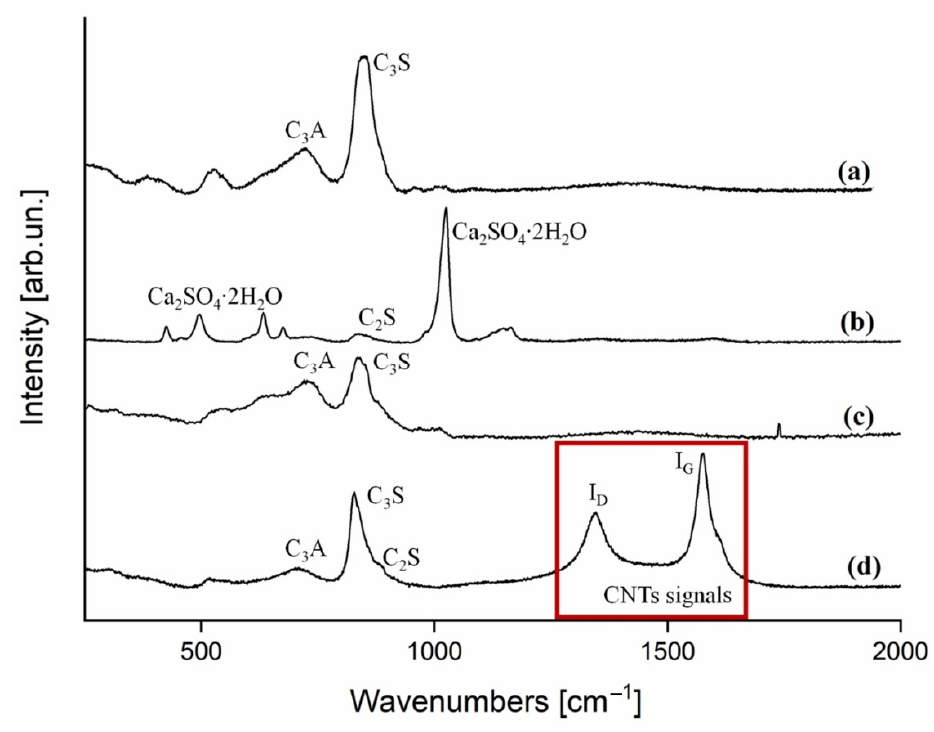
Figure 2. Raman spectra (250–2000 cm − 1 range) collected on ( a ) pristine cement clinker rich in aluminium silicate, ( b ) pristine cement clinker rich in calcium sulphate dihydrate (gypsum), ( c ) cement annealed at 1000 °C, and ( d ) cement after CVD growth.